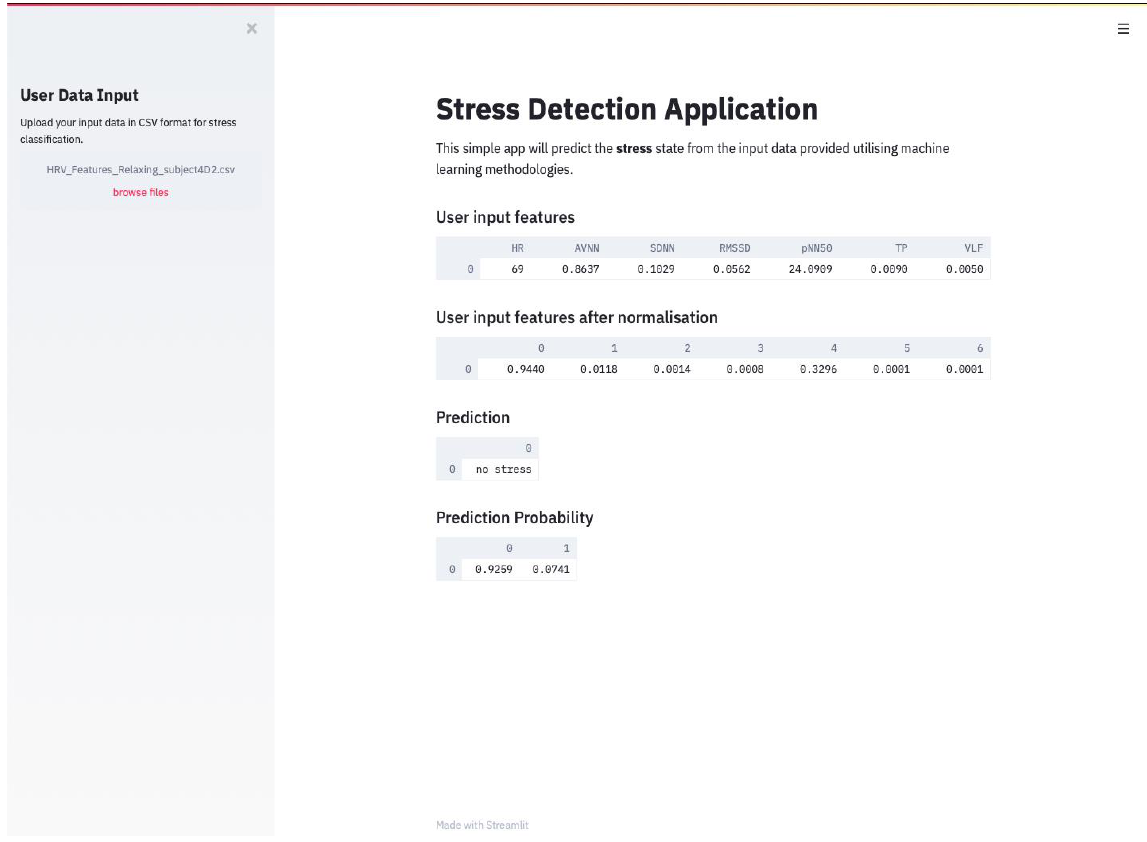
Figure 8. User Interface of the Stress Detection Web Application developed using Streamlit .